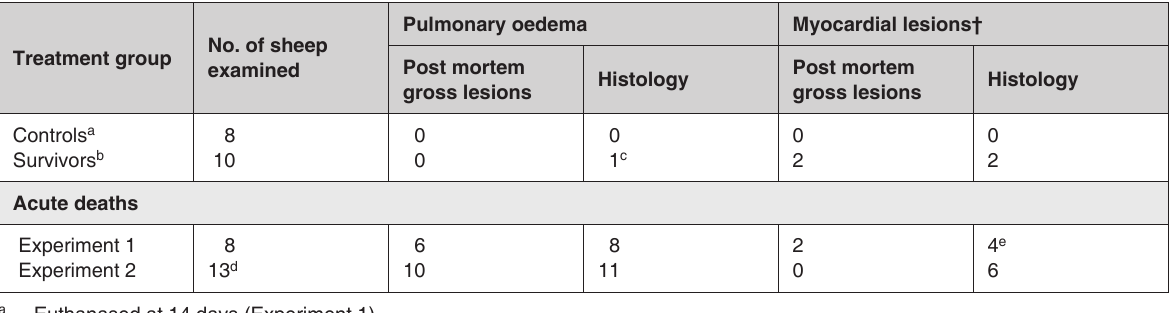
Treatment group